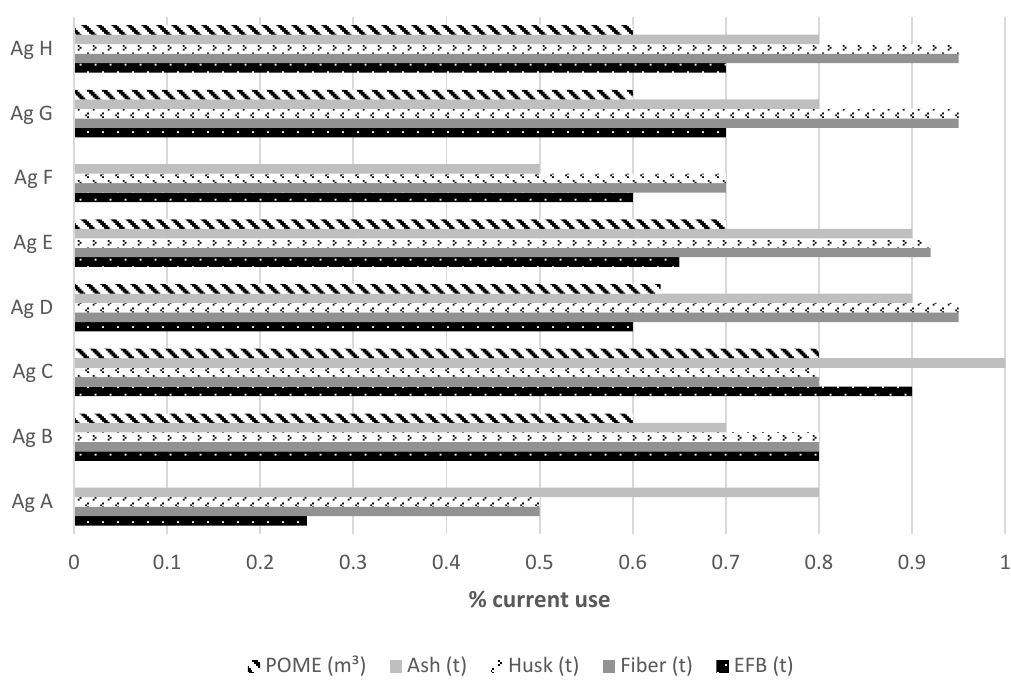
Figure 4. Percentage or degree of the current use of palm oil residues and by-products in the agro-industries in the Casanare Department.